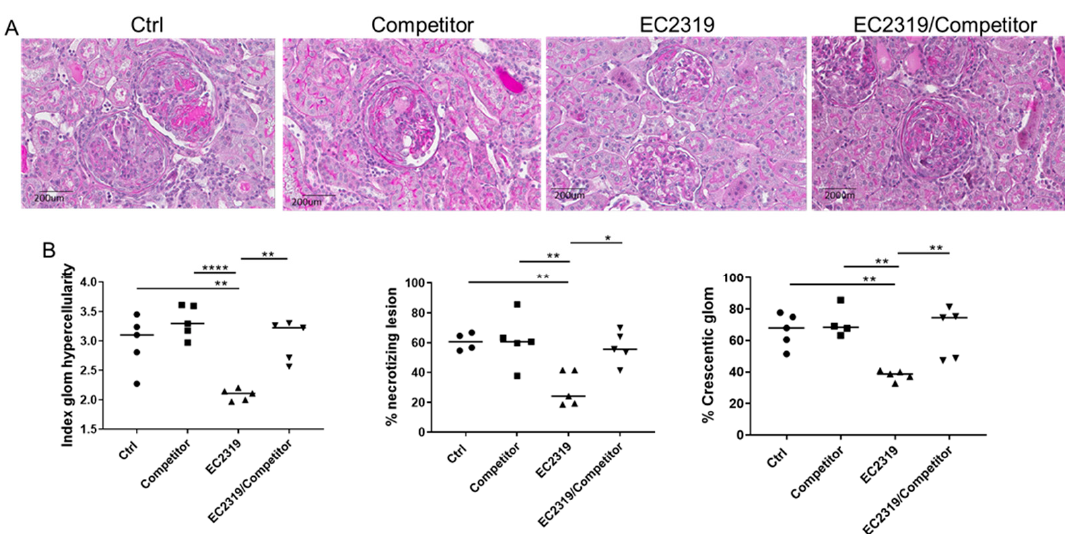
Figure 7. The protective effect of EC2319 in GN is reversed by blocking its binding to folate receptors. ( A ) Periodic acid-Schiff (PAS) staining of kidney sections of WKY rats treated with vehicle, a folate-containing competitor, EC2319, and EC2319 and FA competitor (EC2319/Competitor). The FA competitor does not affect kidney injury in GN. EC2319 reduces kidney damage; this effect is reversed with the simultaneous treatment with the competitor. ( B ) Quantitation of kidney injury in control rats, Competitor, EC2319, and EC2319/competitor-treated rats with anti-GBM GN. Each data point represents sections sampled from five rats and is expressed as mean ± SEM. * p < 0.05, ** p < 0.01, **** p < 0.0001. PAS staining, original magnification × 400. • Control, (cid:4) Competitor, (cid:78) EC2319, (cid:72)